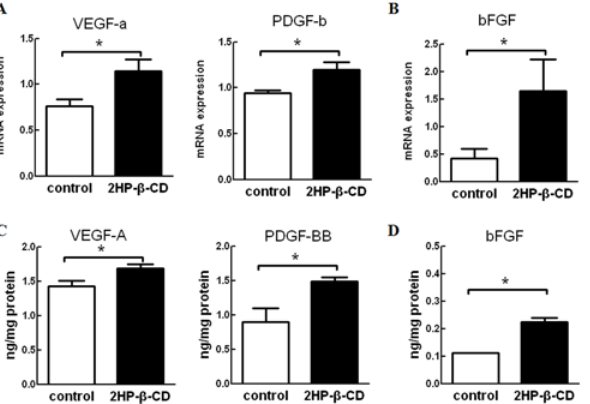
Fig 1. Angiogenesis-related mRNA and peptide expression in HUVECs and HASMCs. Expression levels of mRNA for angiogenic factors in HUVECs (A) and HASMCs (B) when treated with 2HP- β -CD (filled) and PBS (open) were determined by real-time PCR. GAPDH was used as an endogenous control. Data represent the mean ± S.E.M. ( n = 4 per group). * p < 0.05. Angiogenesis-related peptide expression in the supernatants of HUVECs (C) and HASMCs (D) when treated with 2HP- β -CD (filled) and PBS (open) were determined by ELISA. Data are reported in nanograms per mg of proteins and represent the mean ± S.E.M. ( n = 3 experiments). * p <